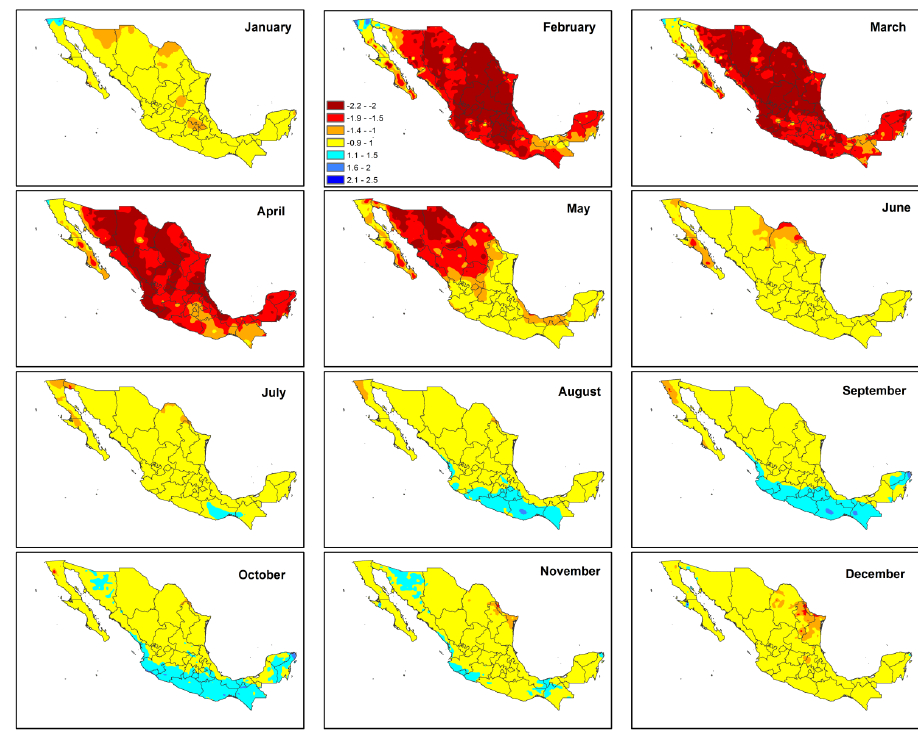
Figure 12. Drought monitoring based on TRMM 3B42 six-month Standardized Precipitation Index for 2011.